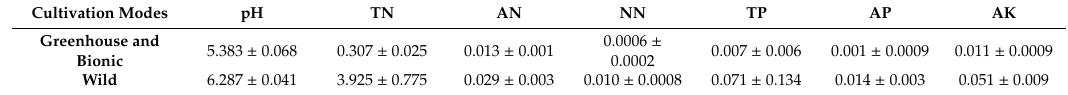
Table 1. Soil factors in different cultivation modes.